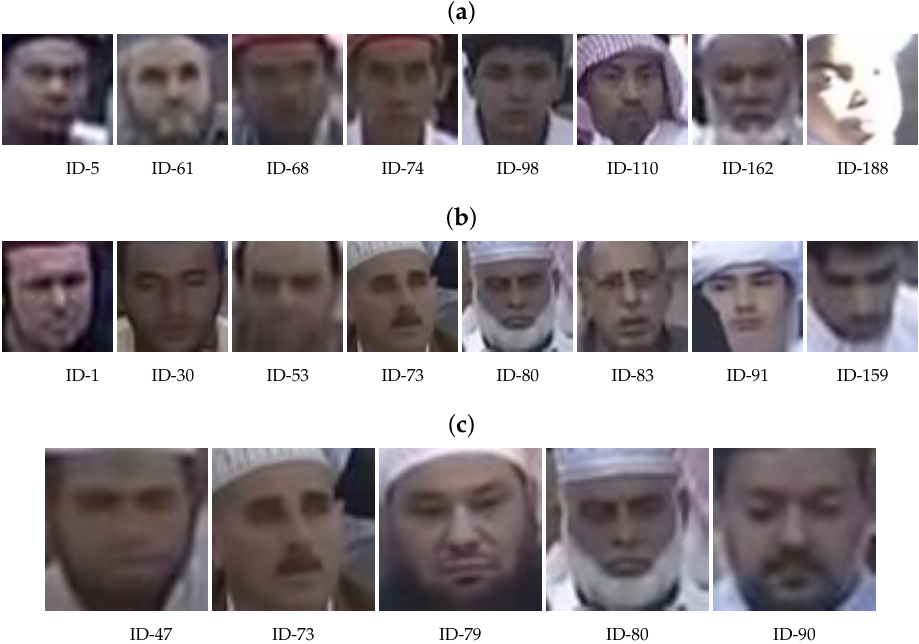
Figure 14. Sampled face images from the dataset, where ( a ) shows un-registered personals, ( b ) regis- tered personals and ( c ) the registered missing